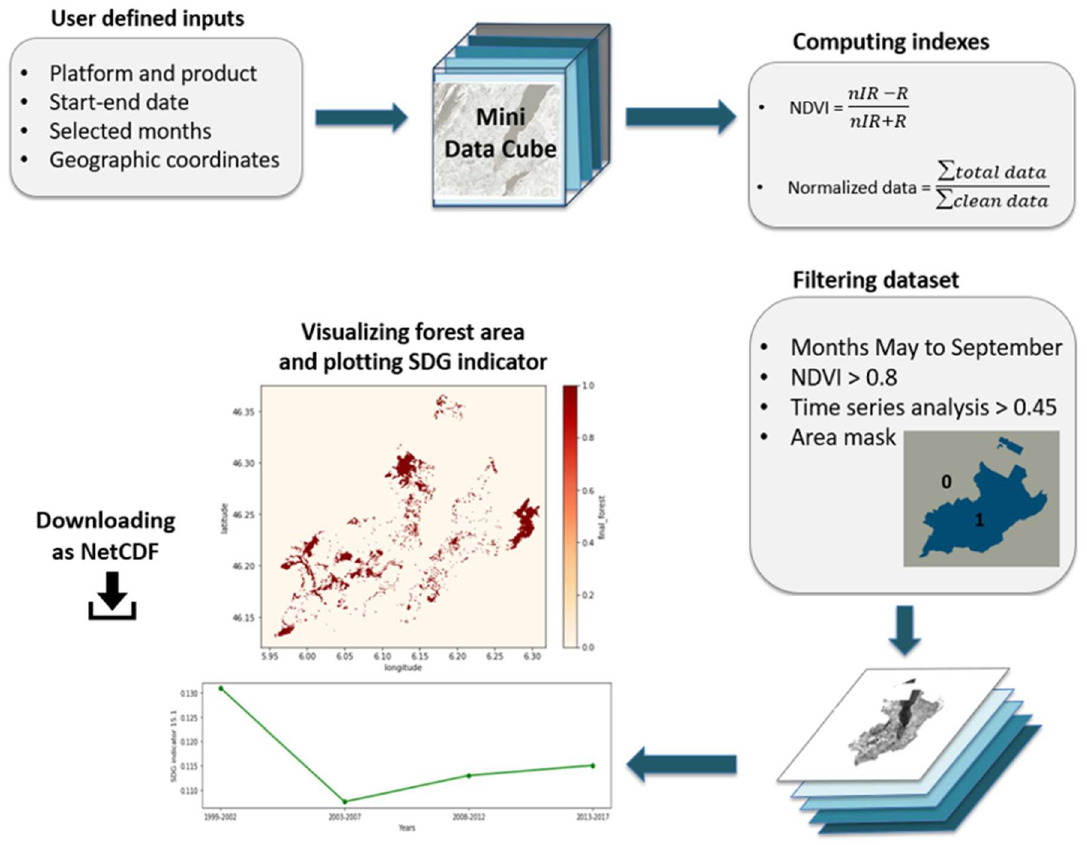
Figure 3. Forest detection algorithm workflow.